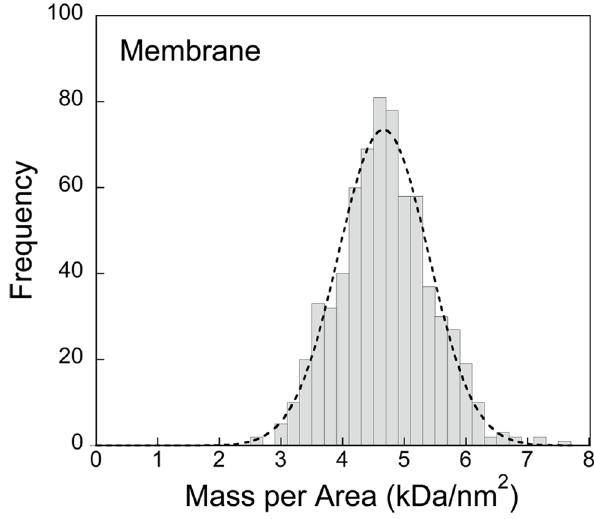
Figure 6. Histogram of the mass-per-area distribution for a collapsed, flat population of Spiroplasma membrane vesicles. A Gaussian fit (r 2 =0.97) is superimposed on the histogram suggesting a normal distribution. The average mass density per unit area of membrane is 4.67 6 0.70 kDa/nm 2 (SD).